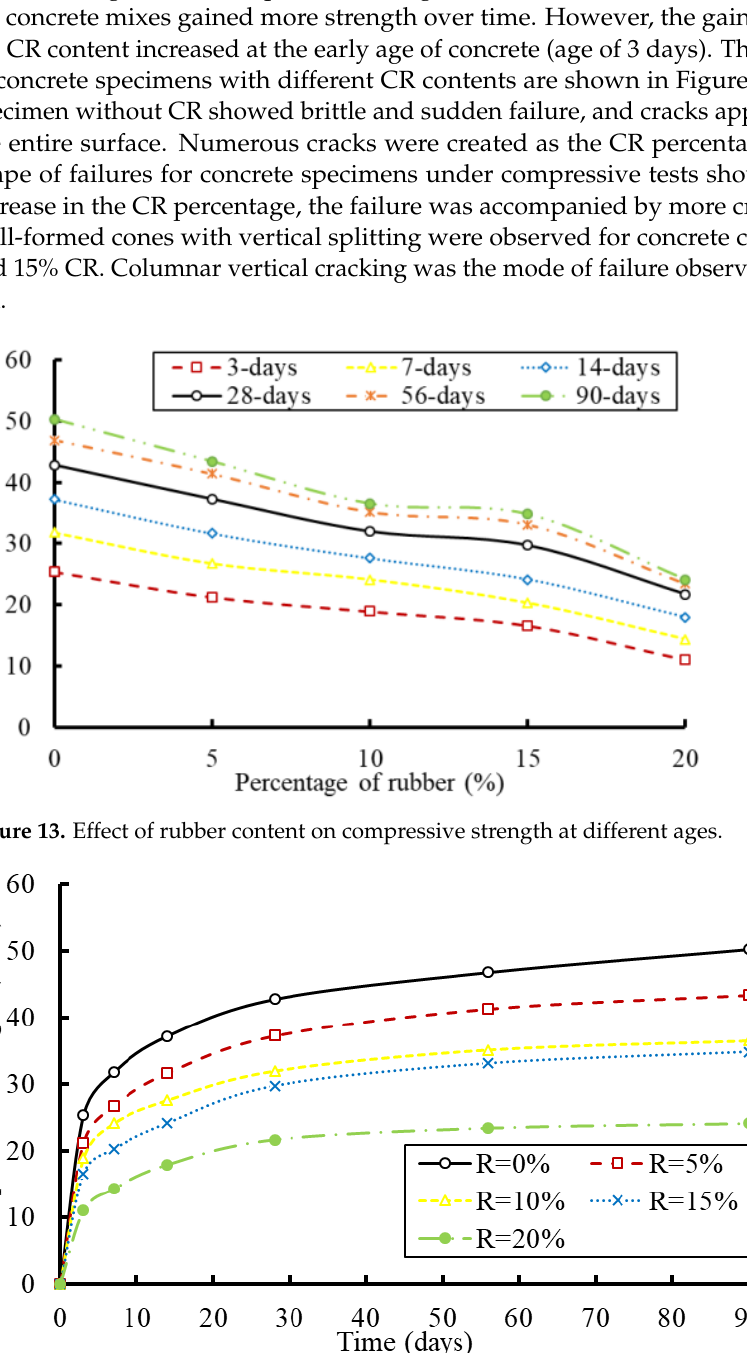
Figure 14. Effect of the concrete age on the compressive strength of concrete with different CR content ratios.